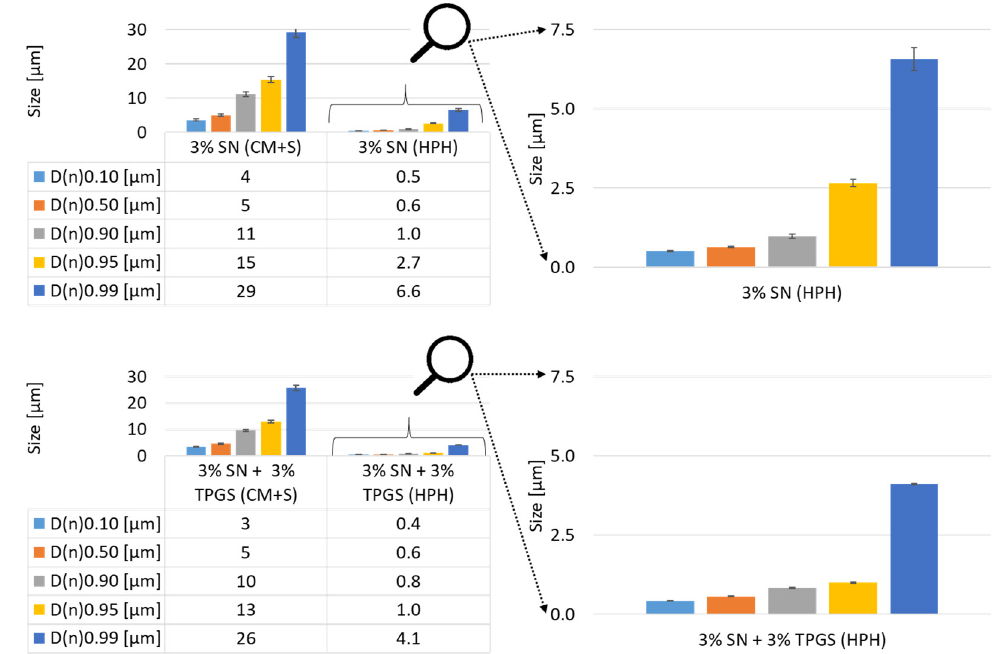
Figure 4. Volumetrically based size distribution of unprocessed and processed SN samples. Top, left: Without surfactant. Bottom, left: With surfactant. Right: Rescaled results for the corresponding PlantCrystals samples for better visualization and comparison.